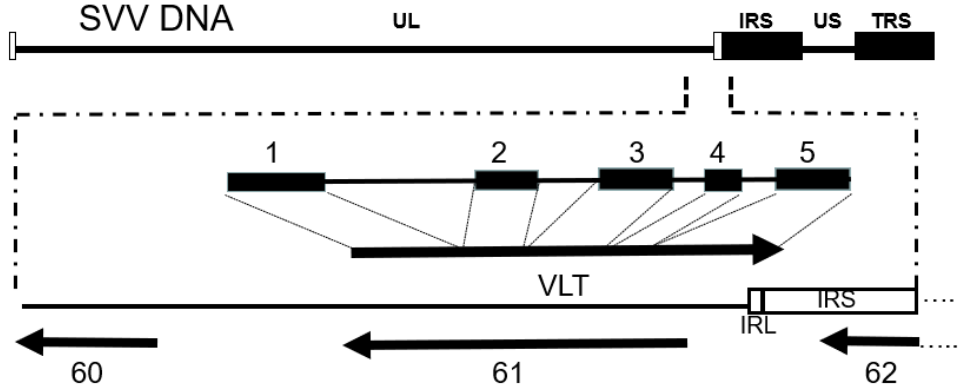
Figure 5. The SVV latency associated transcript (VLT) is a spliced RNA consisting of five exons (blocks) and introns (lines) mapping to the UL/IRS junction of SVV DNA and antisense to ORF 61. Multiple other isoforms are also transcribed from this locus during lytic infection. From Braspenning et al. [32].